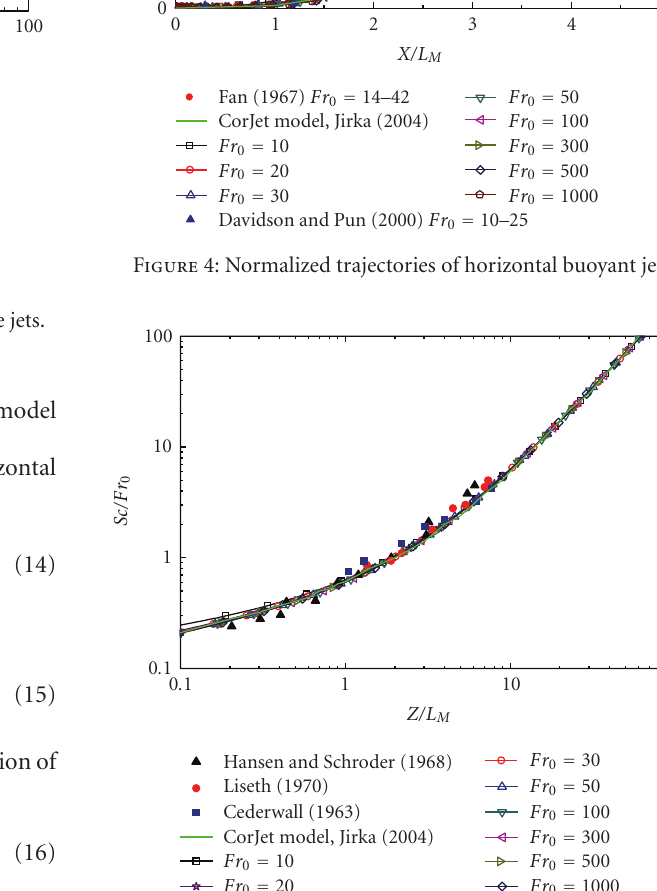
Figure 5: Normalized centerline dilutions of horizontal buoyant